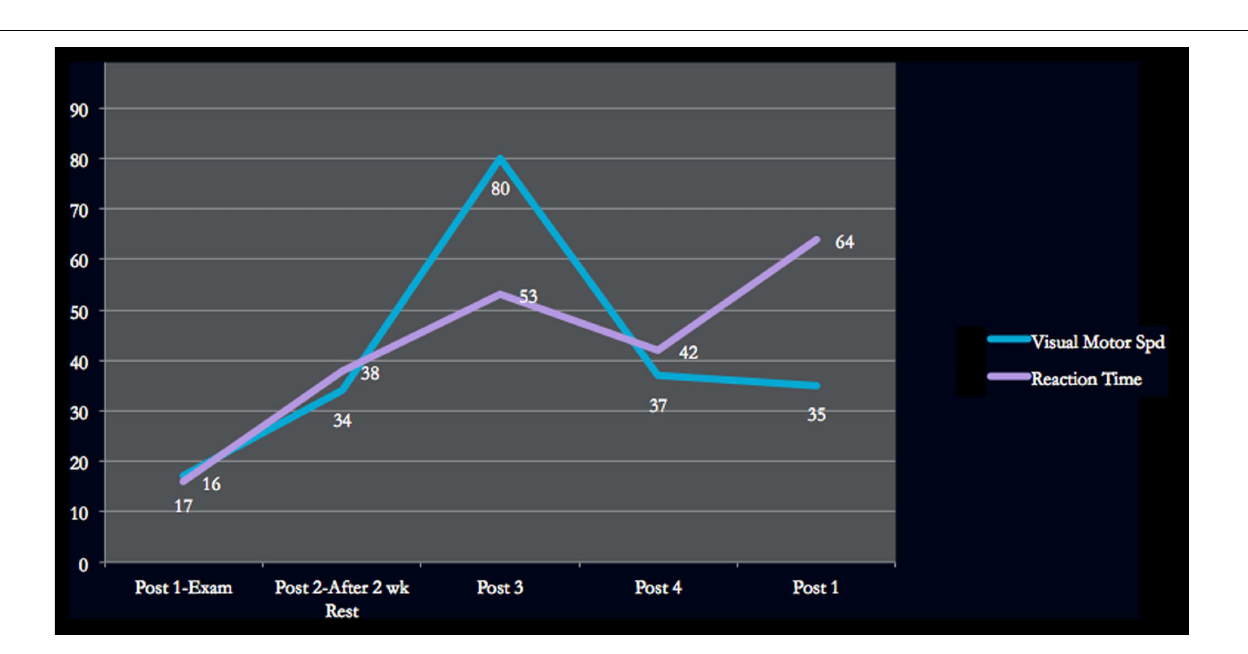
FIGURE 3 |Visual Motor Speed/ReactionTime ImPACT